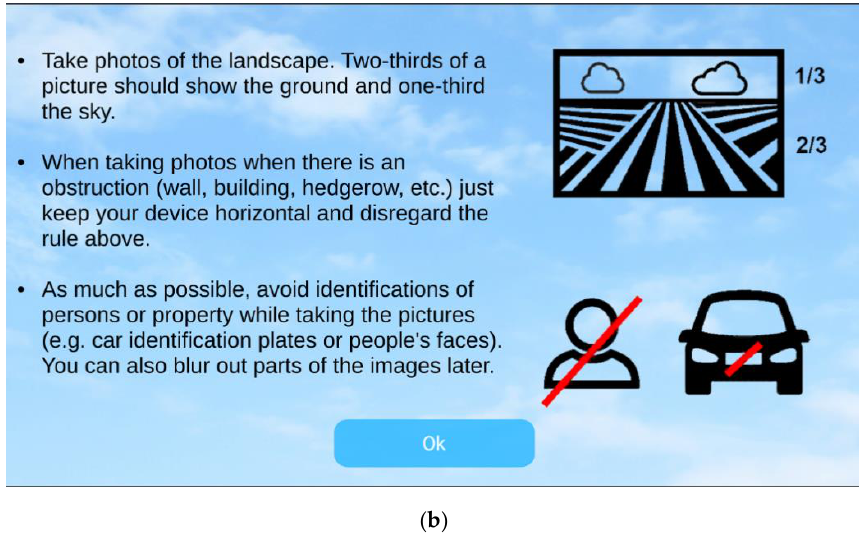
Figure 2. Screenshots from the FotoQuest Go Europe app showing ( a ) an example of a built-in feature in the mobile app that guides the user to take a photograph in one of the cardinal directions and ( b ) advice in the app about taking photographs.